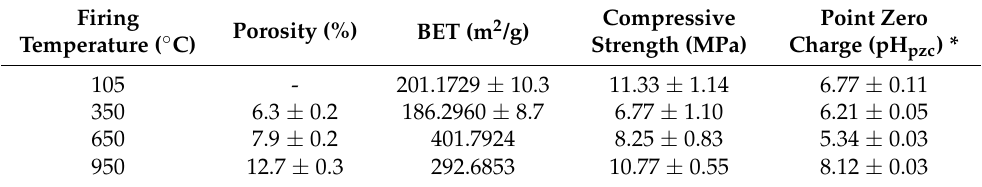
Table 3. The main performance characteristics of